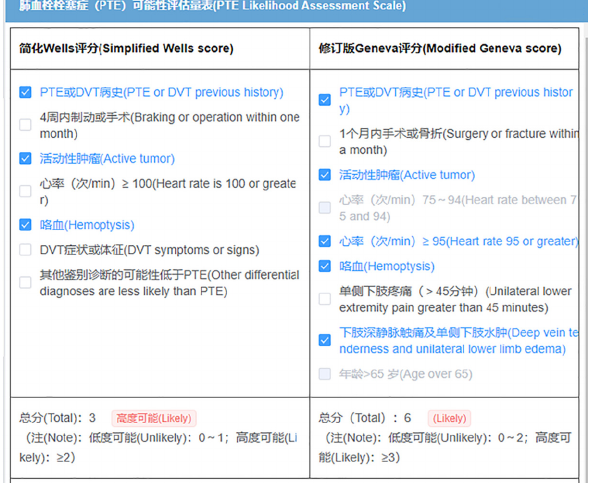
Figure 7. The scoring interface in the actual application process. Table 7. Comparison of evaluation results. Table 7. Comparison of evaluation